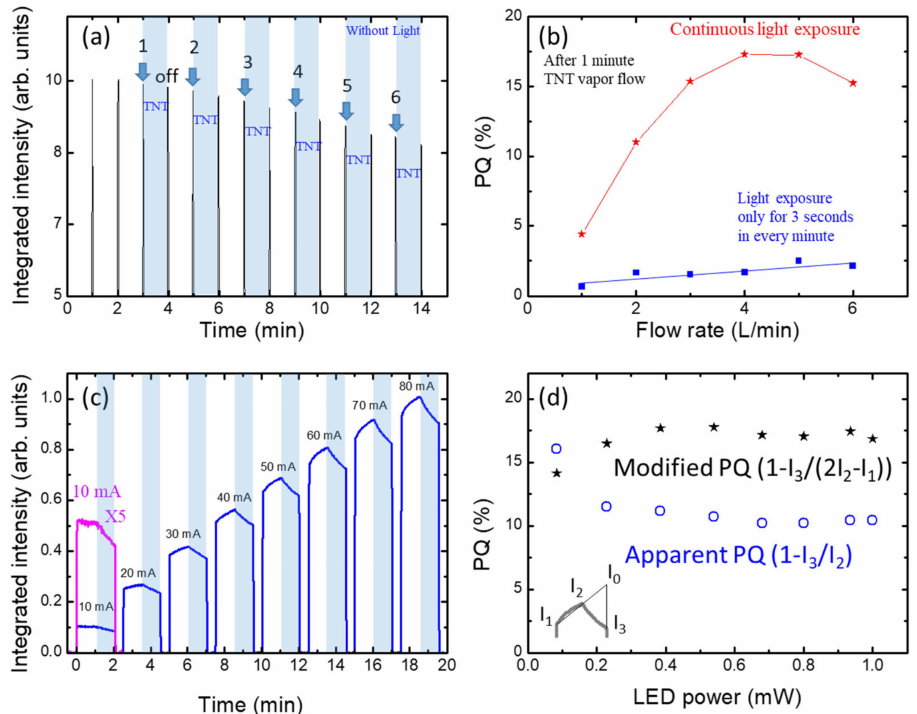
Figure 7. ( a ) Time-dependent integrated PL intensity with various flow rates observed with glass/PEE films. LED illumination was only for 3 s. Blue shaded parts indicate the pump-on period and the arrows indicate the flow rate change. ( b ) PQ values calculated from the raw data obtained from ( a ). The PQ values were compared with the raw data from Figure 5a and the effect of continuous LED illumination was observed. ( c ) Integrated intensity of glass/PEE film with various LED powers. LED currents are indicated. Blue shaded parts indicate the pump-on period with 6 L/min flow rate. ( d ) The PQ values were obtained from ( c ). Modified PQ (1 − I 3 /(2I 2 − I 1 )) calculated based on the assumption that the intensity increases linearly with